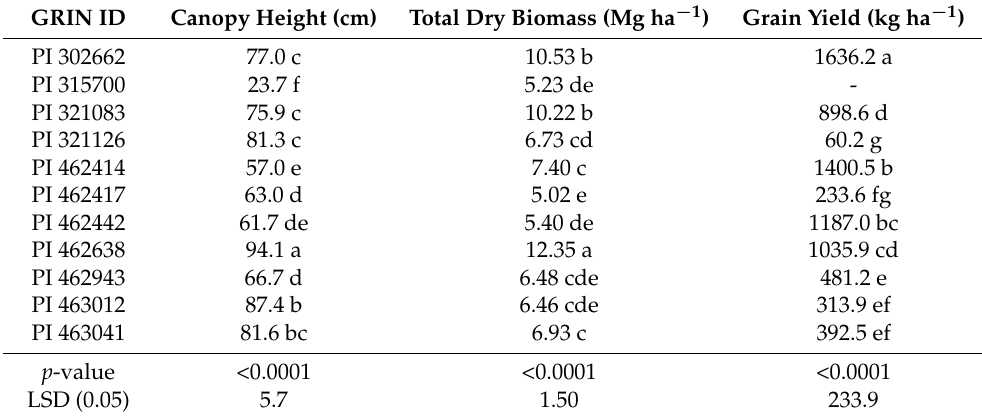
Table 2. Canopy height, total dry biomass, and grain yield of 11 accessions of finger millet at 165 days after planting when all accessions had completed reproduction at El Reno,